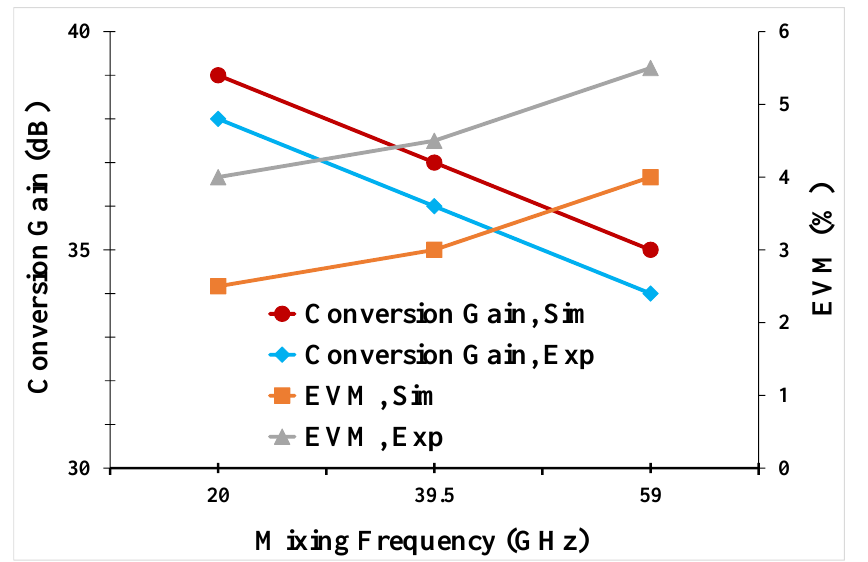
Figure 6. Conversion gain and EVM of the signal to be up-converted at frequencies ranging from f s + f IF = 20 GHz to 3 f s + f IF = 59 GHz for simulation (Sim) and Experimentation (Exp) studies.